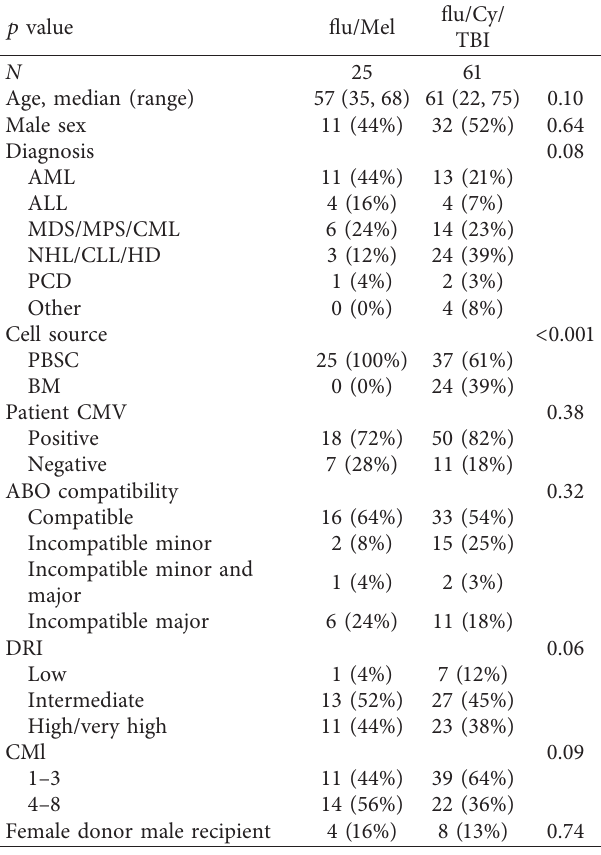
Table 2: Patients’ characteristics in two